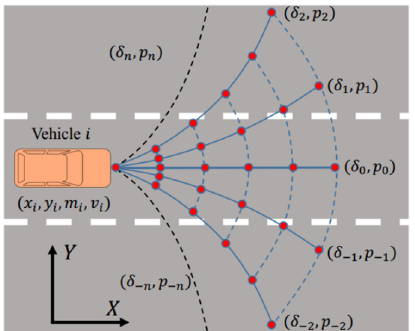
Figure 7 Trajectories based on the steer angle and turning-probability